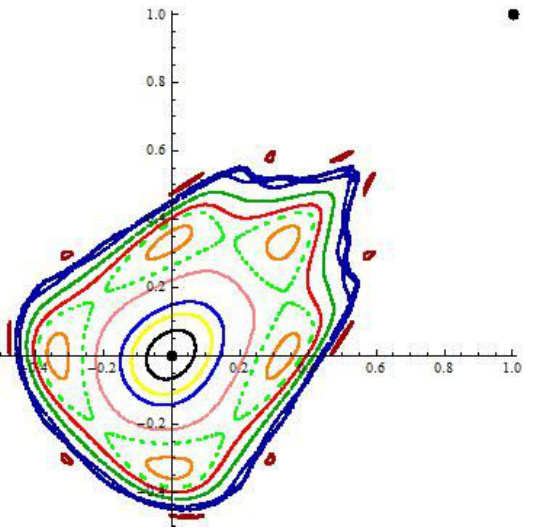
Figure 6. Some possible orbit (S.P.O.) around the elliptic equilibrium ( 0,0 ) for α = 0.5 and β =